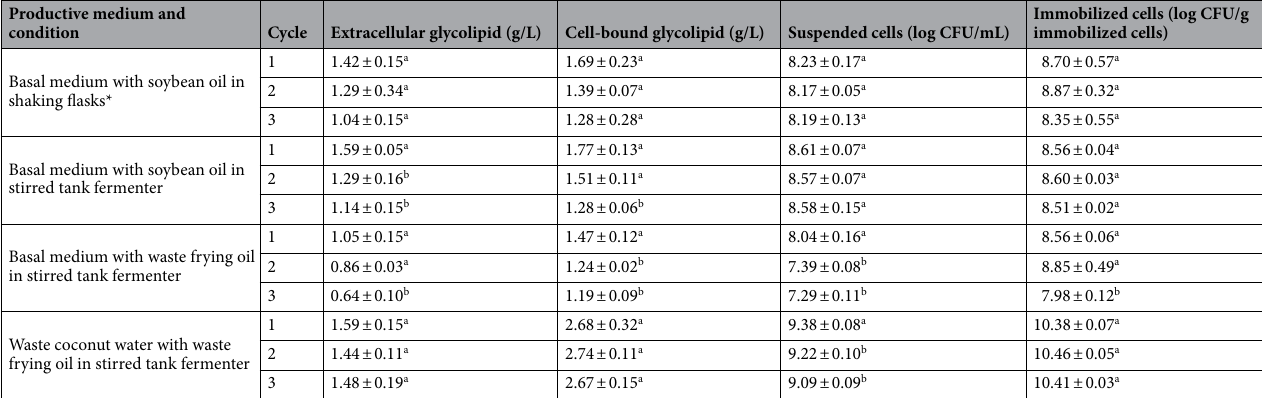
Table 2. Semicontinuous production of glycolipids using different productive media under a stirred tank fermenter. The glycolipid concentrations were based on the volume of productive medium, while the numbers of suspended and immobilized cells were determined at the end of the production cycle. Data are presented as the mean ± standard deviation (n = 3). Two-way ANOVA: Tukey’s multiple comparison test was used for statistical analysis. Different letters represent statistically significant differences ( p < 0.05) in different production cycles within the same productive medium and condition. *The data were obtained from 14